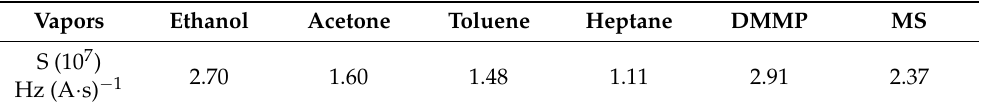
Table 2. S values for the six